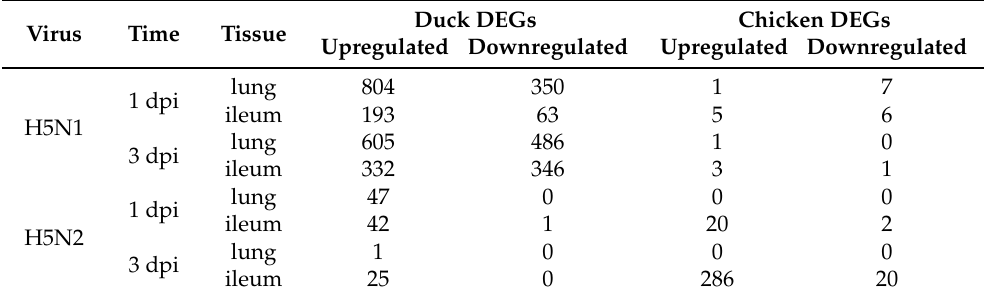
Table 1. Numbers of differentially expressed genes (DEGs) in duck and chicken for the treatments with H5N1 (HPAI) and H5N2 (LPAI) virus after 1 and 3 days post-infection (dpi). The table is split into upregulated ( LFC > 0.58) and downregulated genes ( LFC < − 0.58). Duck DEGs Chicken DEGs Virus Time Tissue Upregulated Downregulated Upregulated Downregulated lung 804 350 1 7 1 dpi ileum 193 63 5 6 H5N1 lung 605 486 1 0 3 dpi ileum 332 346 3 1 lung 47 0 0 0 1 dpi ileum 42 1 20 2 H5N2 lung 1 0 0 0 3 dpi ileum 25 0 286